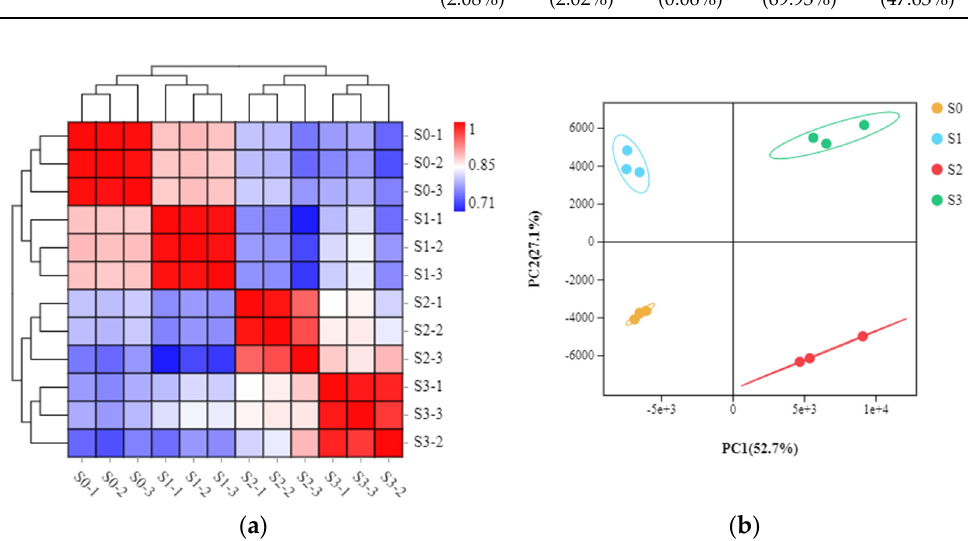
Figure 3. Pairwise Pearson correlation coefficients of the sequencing data from three replicates of each sample collected at the four statuses ( a ). Principal component analysis (PCA) of transcriptome data of the samples collected at the four statuses ( b